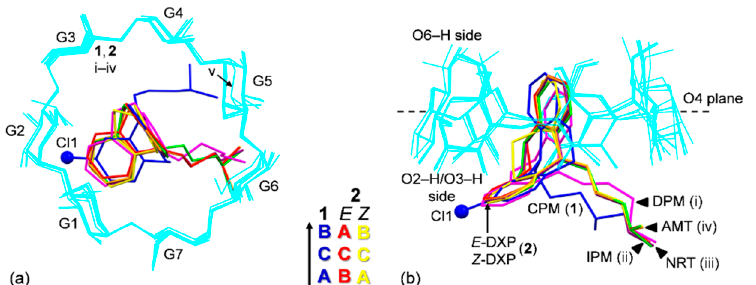
Figure 3. Structure overlays of six β -CDs (cyan wireframes) in complex with various TCAs (sticks), CPM ( 1 ; blue), DXP ( 2 ; E isomer (red), Z isomer (yellow)), DPM (i; magenta), IPM (ii; green), NRT ( iii ; violet), AMT ( iv ; orange) [14,15], and in the uncomplexed β -CD ∙ 12H 2 O (v) [29], viewed from ( a ) the top and ( b ) the side. Cl group on C3 (A-ring) of CPM ( 1 ) is emphasized with ball model. Note that the different inclusion structures from the distinct alignments of the A-C-B-rings of drugs CPM and DXP in the β -CD cavity are highlighted in the middle; see also Figure 4.